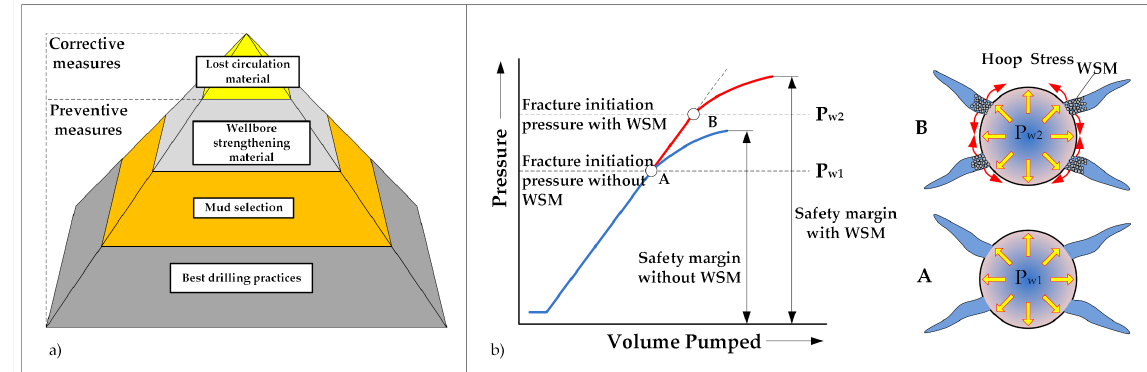
Figure 1. Preventive and corrective measures hierarchy ( a ) and wellbore strengthening ( b